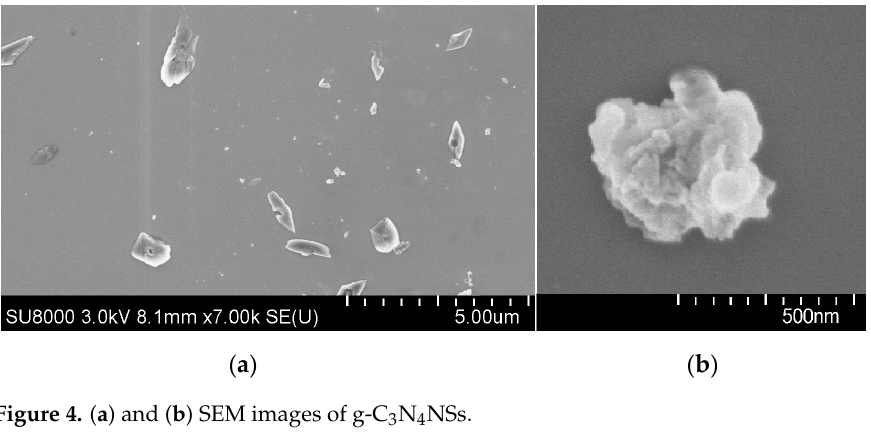
Figure 4. (a) and (b) SEM images of g-C 3 N 4 NSs. Figure 4. ( a ) and ( b ) SEM images of g-C 3 N 4